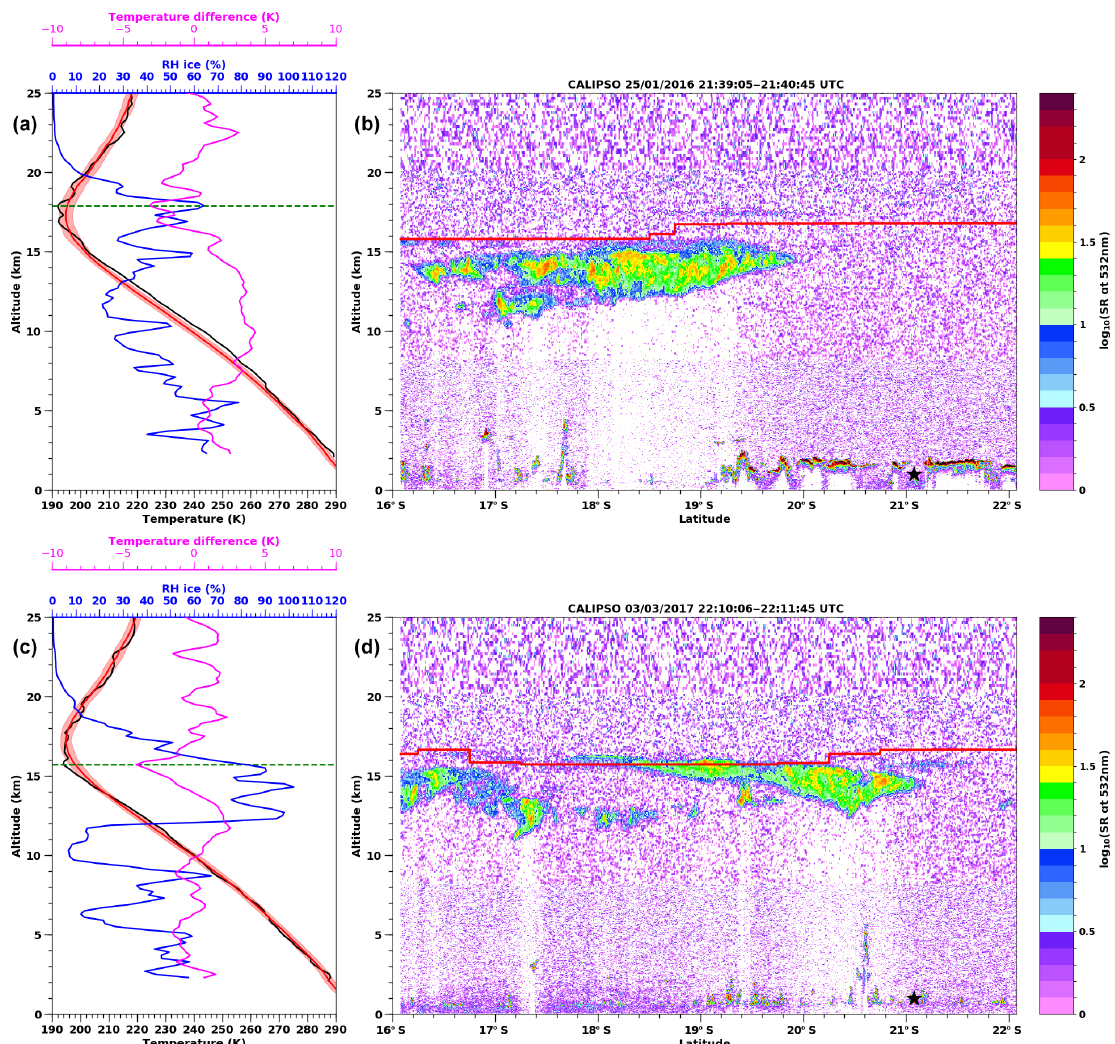
Figure 5. (a, c) Vertical profiles of temperature and relative humidity with respect to ice (black and blue line, respectively) measured on 25 January 2016 at 17:52UTC and 3 March 2017 at 18:00UTC. The dashed green line corresponds to the cold point tropopause. The NDACC/SHADOZ climatological mean summertime (DJFM) profile of temperature (red line), the ± 1 standard deviation (red shading) and temperature anomaly (magenta line) are also shown. (b, d) Latitude–altitude distribution of CALIOP backscattering ratio at 532nm along CALIOP track near Réunion Island on 25 January 2016 (b) and 3 March 2017 (d) . The mean longitude difference between the CFH profile and the CALIOP track is 2.4 ◦ on 25 January 2016 and 5.3 ◦ on 3 March 2017. The red curve on each CALIOP plot corresponds to the tropopause height provided by the GEOS-5 global model data available in the CALIPSO level 1 data files. The latitude of the Maïdo Observatory is indicated by the black star on each CALIOP